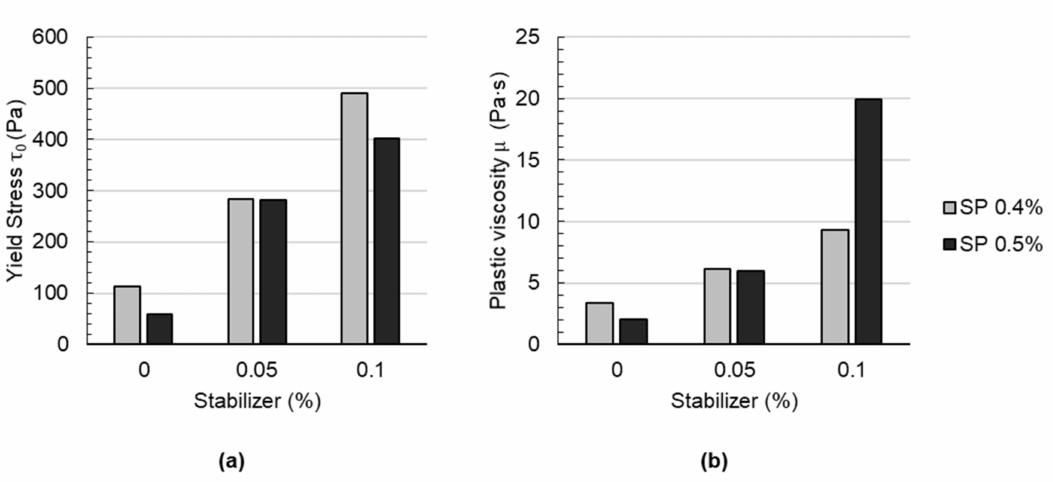
Figure 4. Rheological parameters of the sprayed concrete: ( a ) yield stress and ( b ) plastic viscosity of mortars containing various amounts of stabilizer and superplasticizer.